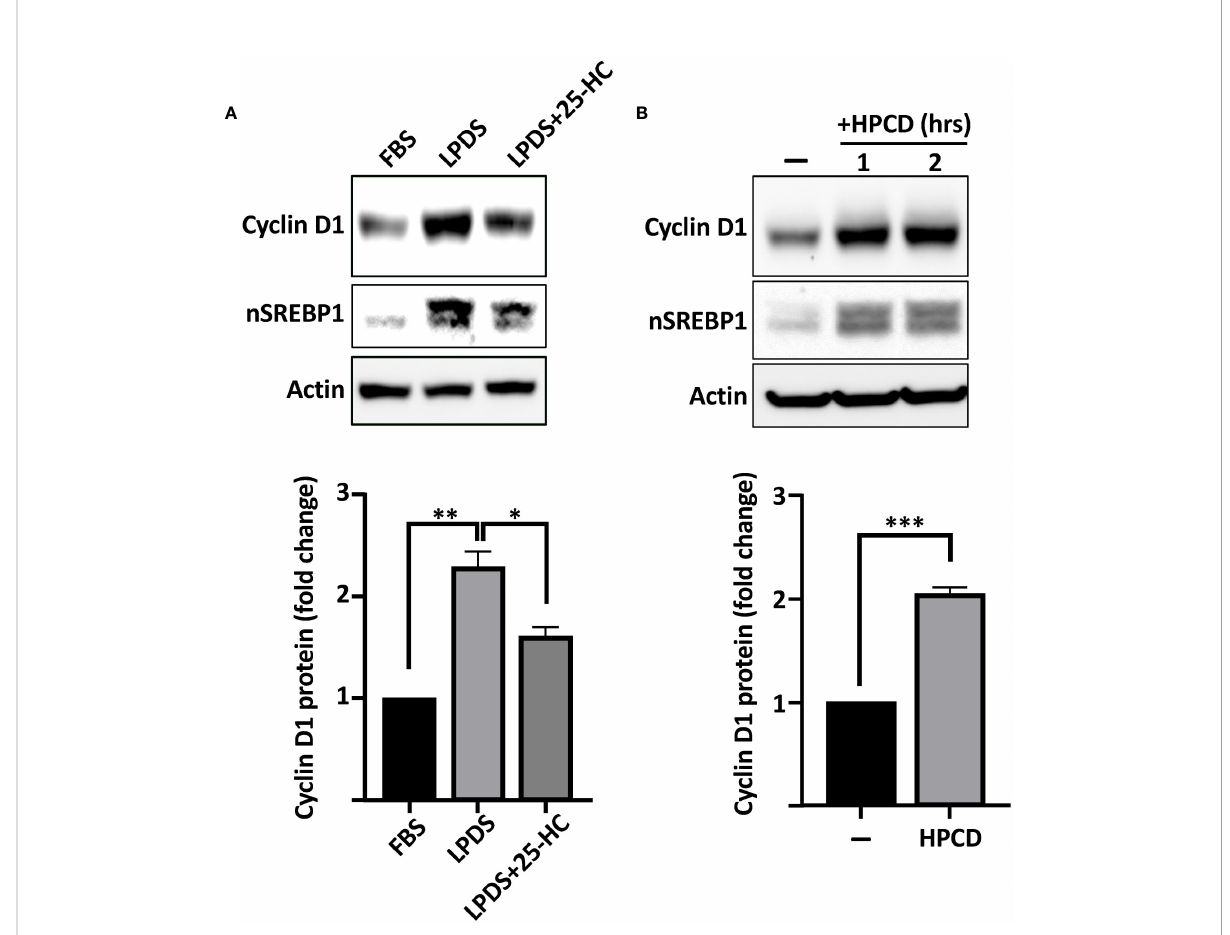
FIGURE 2 The expression of cyclin D1 responds to physiological changes in SREBP activity. (A) HepG2 cells were grown in media supplemented with regular serum ( FBS ) or lipoprotein-de fi cient serum ( LPDS ). Where indicated, the LPDS was supplemented with 25-hydroxycholesterol ( 25-HC , 5 m g/ml) for 8 h before the end of the experiment. The levels of cyclin D1, nuclear SREBP1 ( nSREBP1 ), and b -actin were determined by Western blotting ( upper panel ). The relative levels of cyclin D1 were quanti fi ed and are presented as fold change ( lower panel ). (B) HepG2 cells grown in regular media were left untreated or treated with 1% HPCD (w/v) for the indicated times. The levels of cyclin D1, nuclear SREBP1 ( nSREBP1 ), and b -actin were determined by Western blotting ( upper panel ). The relative levels of cyclin D1 in untreated cells ( − ) and cells exposed to HPCD for 2 h ( HPCD ) were quanti fi ed and are presented as fold change ( lower panel ). Signi fi cance was determined by paired t-tests (B) or one-way ANOVA with Tukey ’ s multiple comparisons adjustment (A) . p-values lower than 0.05 were considered statistically signi fi cant. *p < 0.05, **p